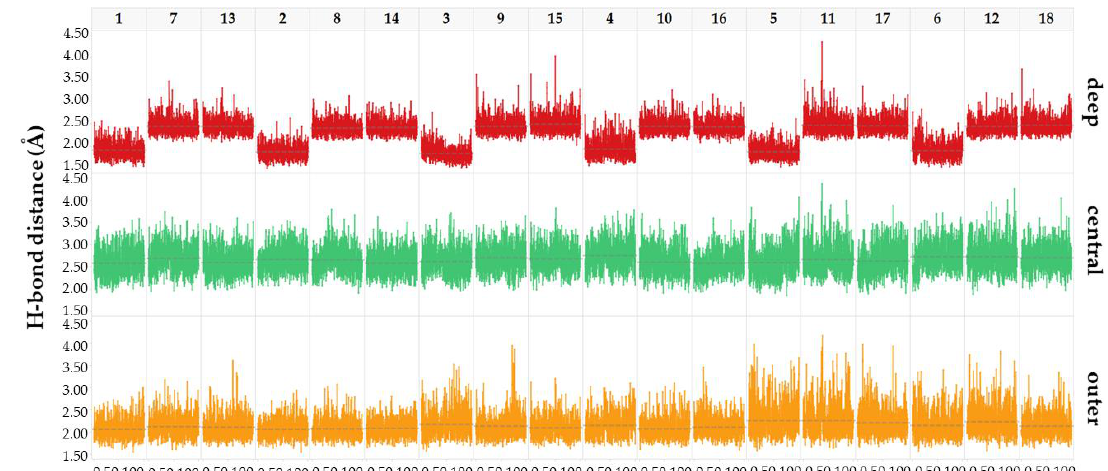
Figure 6. Distance of the deep (red), central (green) and outer (orange) H-bond interactions across 100 ns MD simulation of derivatives 1 – 18 . The plots are ordered per INDZ-IMID 1-IMID 2 triplet. Dashed lines represent the mean value of the H-bond distance.